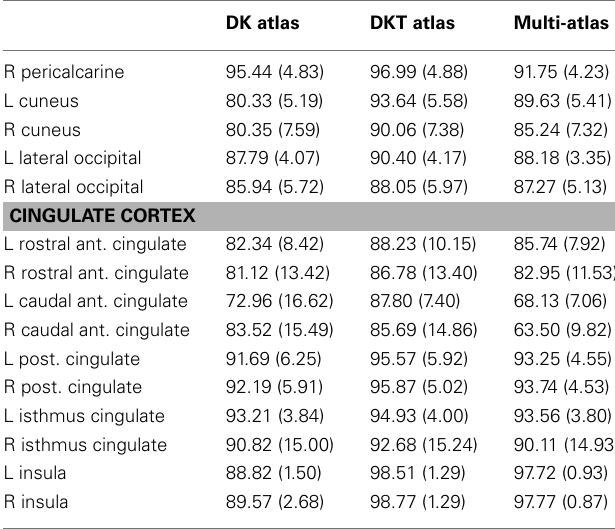
Table 4 | Overlap results of manually and automatically labeled cortical